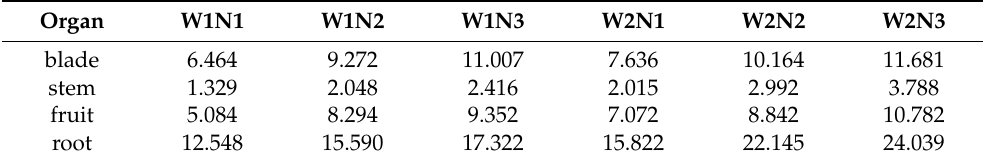
Table 5. The 15 N-N content in vine organs under different treatment conditions at harvest (kg/ha).